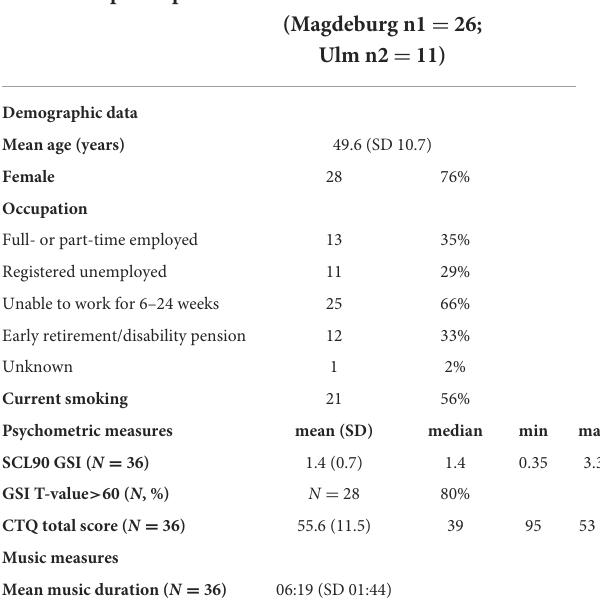
TABLE 1 Demographic Data, psychometric measures, and musical data: SCL90, Symptom Check List; GSI, Global Severity Index; CTQ, Childhood Trauma